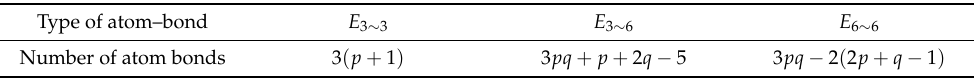
Table 3. Atom–bond partition of SC p q ; p is odd and p < q